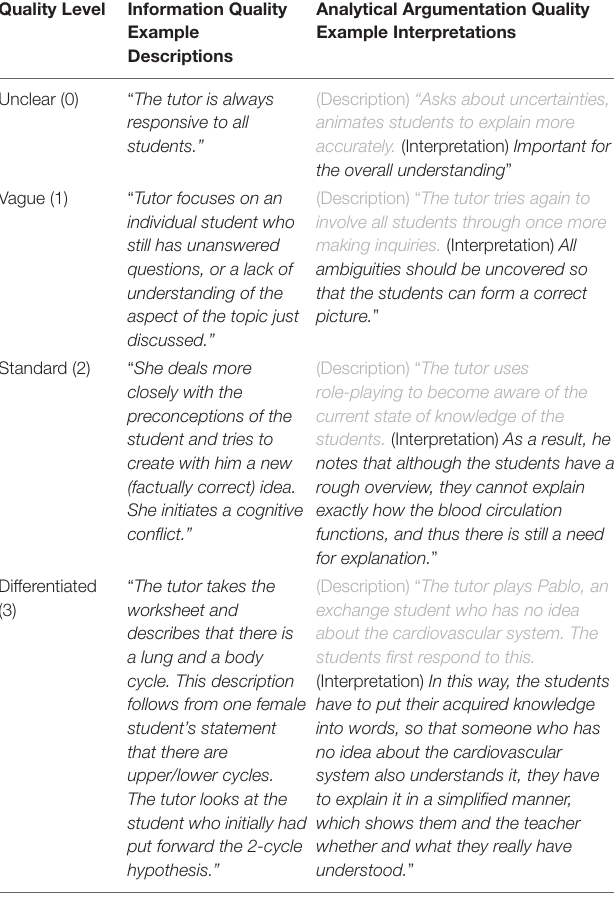
TABLE 3 | Example responses at the four quality levels of information (describing) and analytical argumentation (interpreting). Quality Level Information Quality